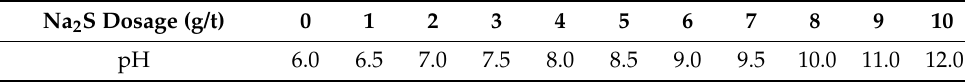
Table A1. Pulp pH at different dosages of Na 2 S.